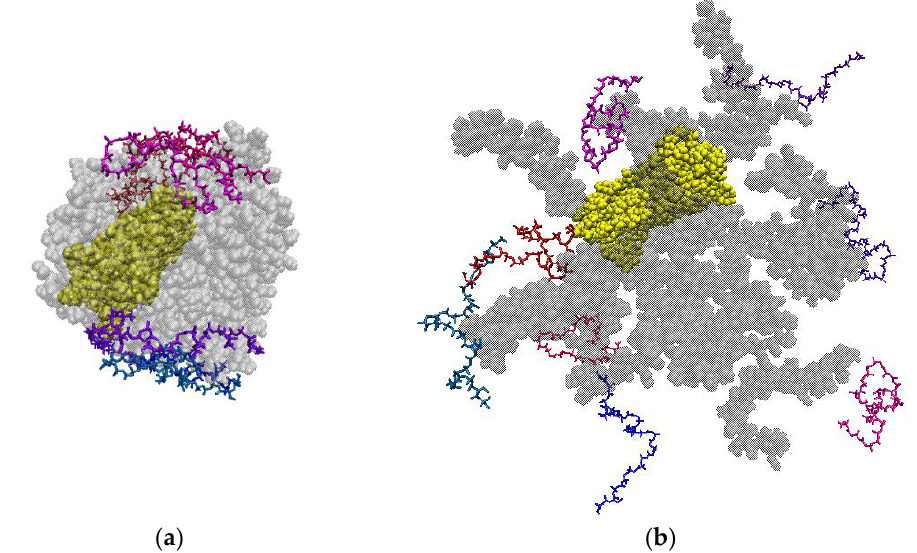
Figure 20. Snapshots of the PHBV/PVP/CNC composite at the beginning ( a ) and at the end ( b ) of the simulation. The PVP macromolecules are shown in grey, PHBV ones in two colors (pink and navy) and the CNC particle is in yellow (DCM molecules are not shown for clarity).